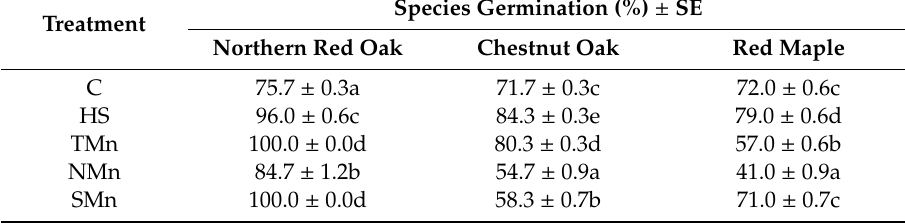
Table 1. Mean 1 seed germination success based on the percentage of seeds that germinated among northern red oak ( Q . rubra L.), chestnut oak ( Q. prinus L.), and red maple ( Acer rubrum L.) with di ff erent treatments 2